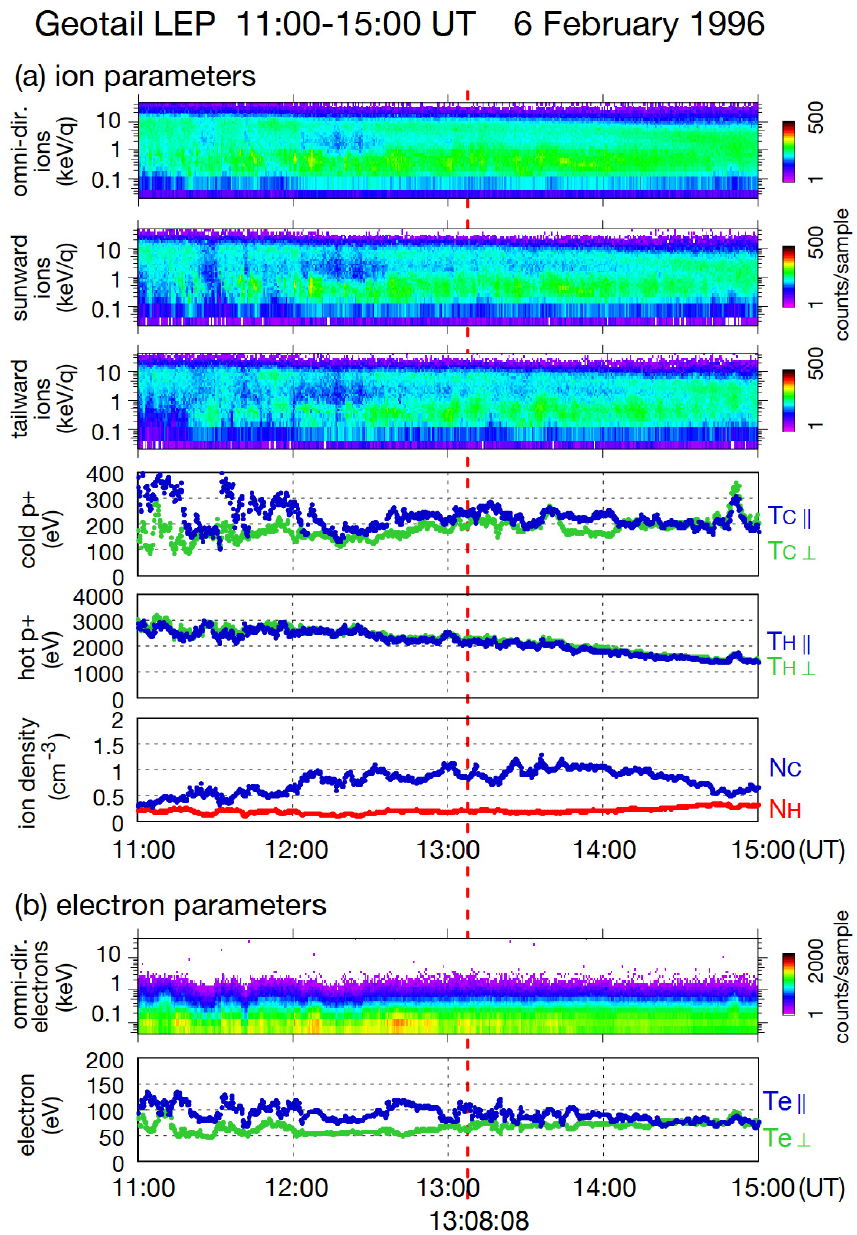
Fig. 4. Geotail observations between 11:00–15:00 UT on 6 February 1996 in a similar format to Fig. 1 but the energy range of the electron E-t spectrogram is from 43eV to